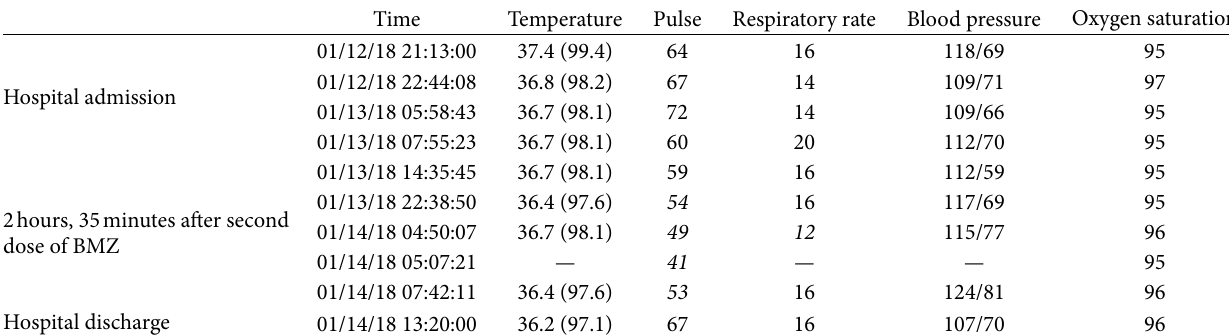
Table 1: Vital signs